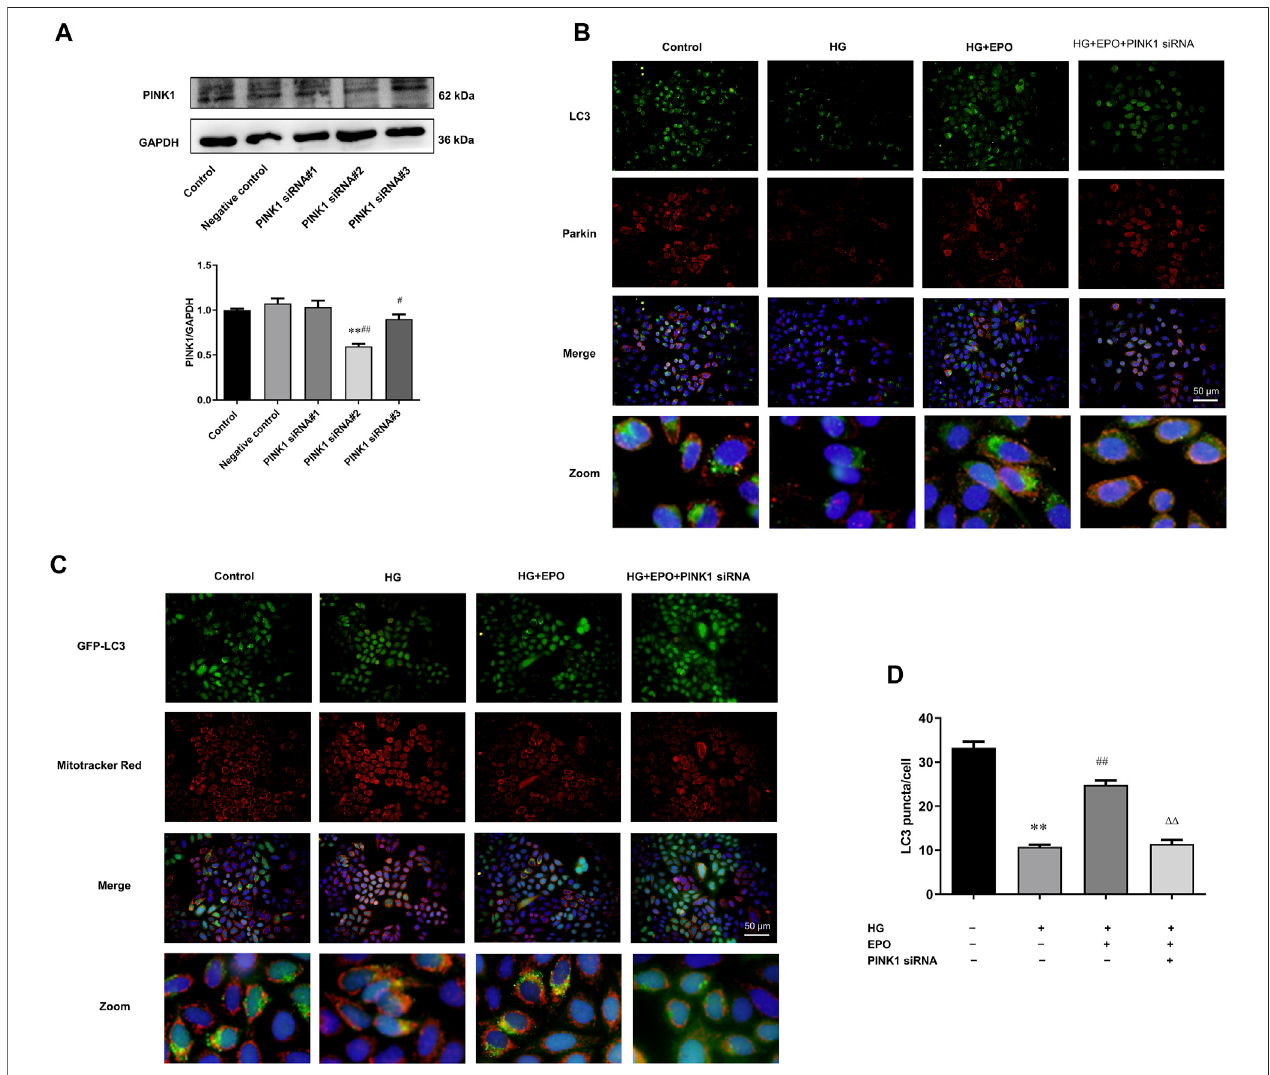
FIGURE 4 | PINK1 knockdown partly abrogated the effect of EPO on the level of mitophagy. (A) Representative immunoblots and quanti fi cation of PINK1 when mesangial cells were treated PINK1 siRNA. Immuno fl uorescence images of the (B) colocalization of LC3 with Parkin as well as the (C) colocalization of GFP-LC3 with mitochondria and (D) quanti fi cation of the number of GFP-LC3 puncta. Values are presented as mean ± SEM, n = 3. ** p < 0.01 vs. Control group; ## p < 0.01 vs. HG group; ΔΔ p < 0.01 vs. EPO group.